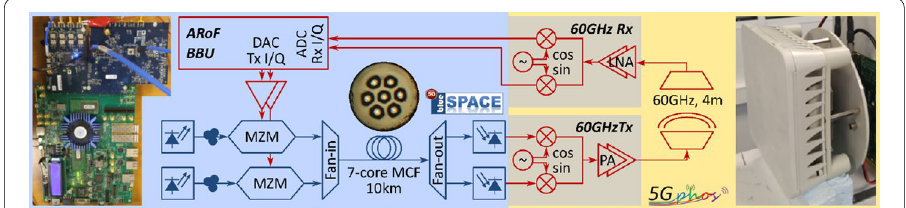
Fig. 4 Experimental setup of the mmWave link of the joint demo. Featuring the key technologies: ARoF BBU, MCF and V‑band antenna